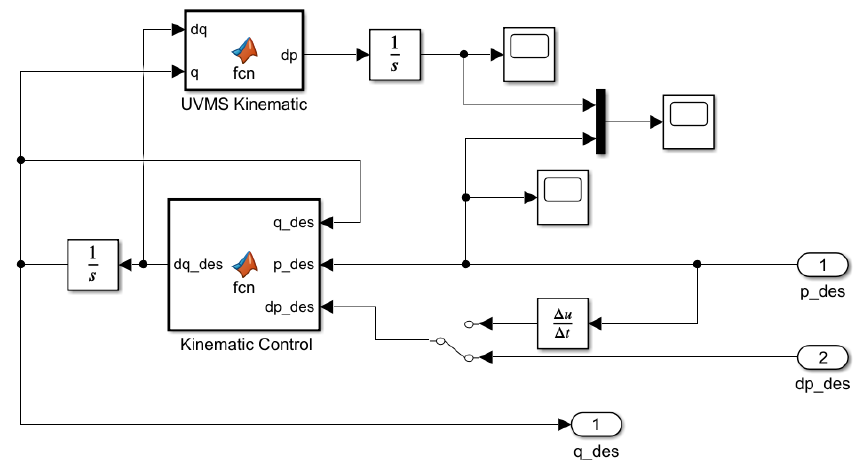
Figure 9. Simulink submodel of kinematic control.